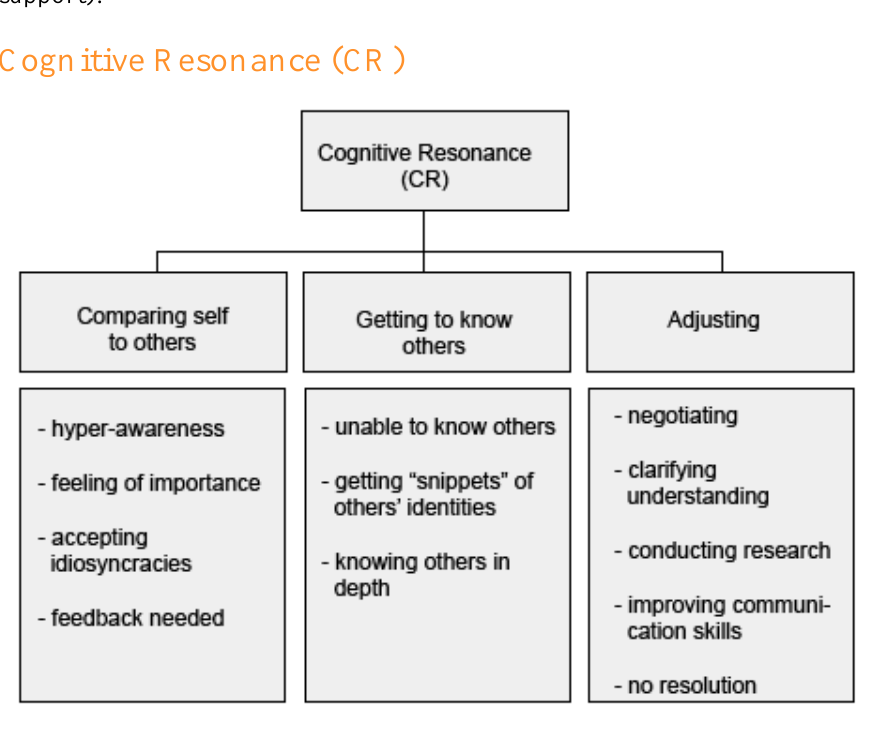
Figure 7 . Cognitive resonance